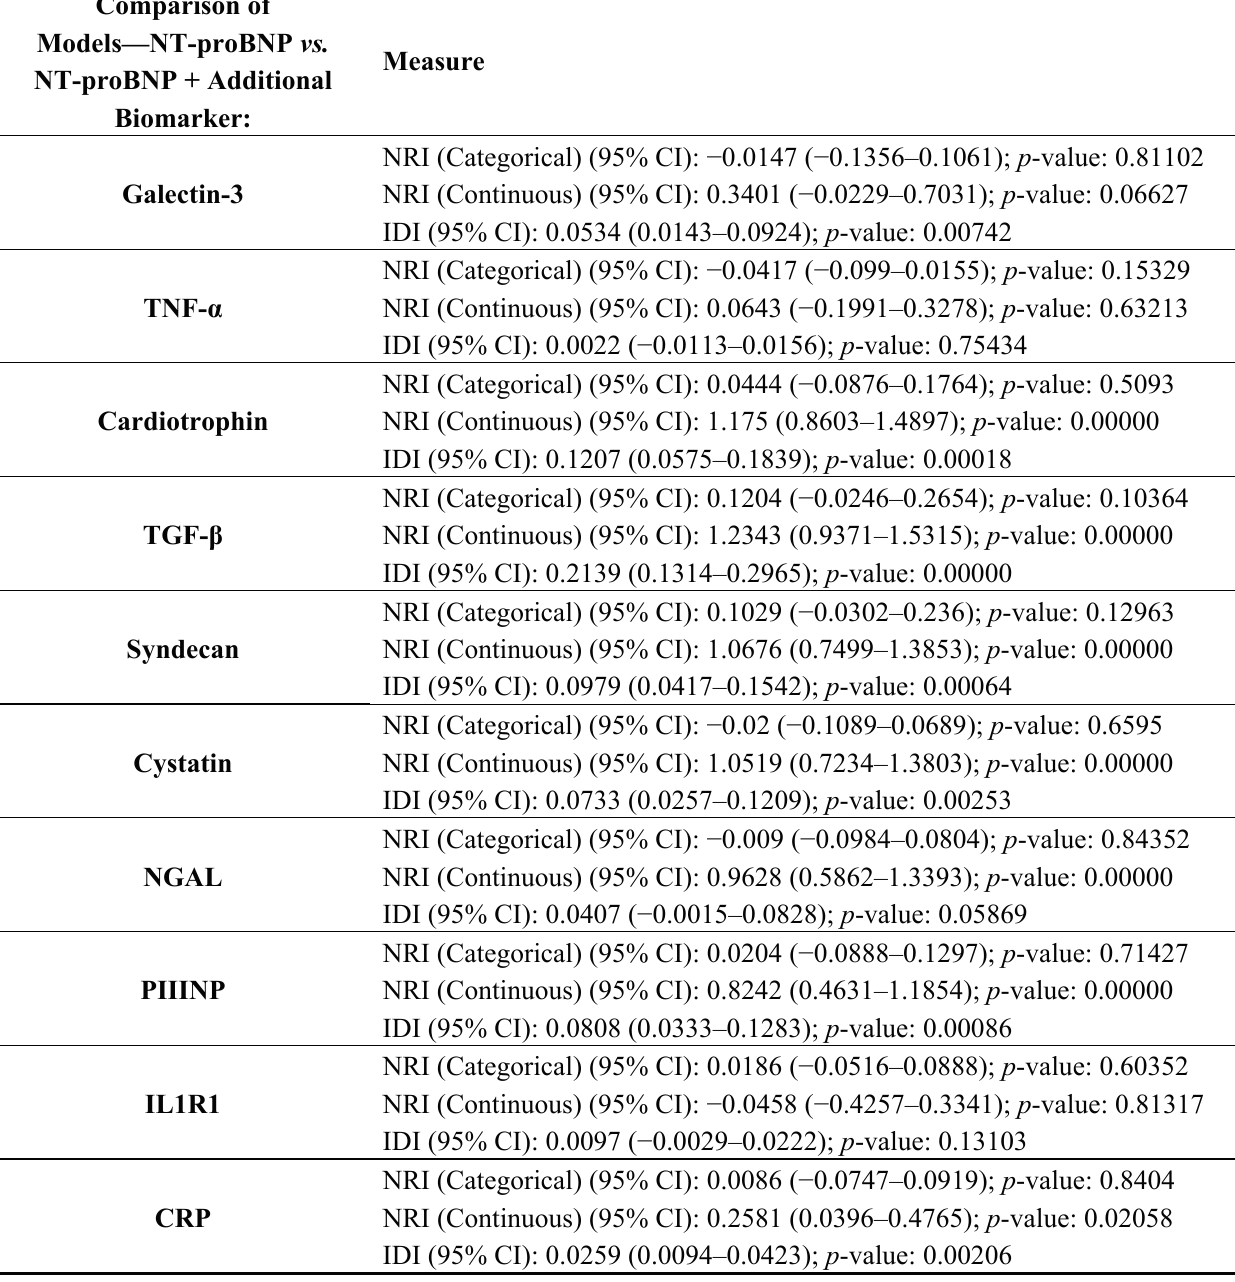
Table 6. Comparison of the basic model of NT-proBNP with models extended by an additional